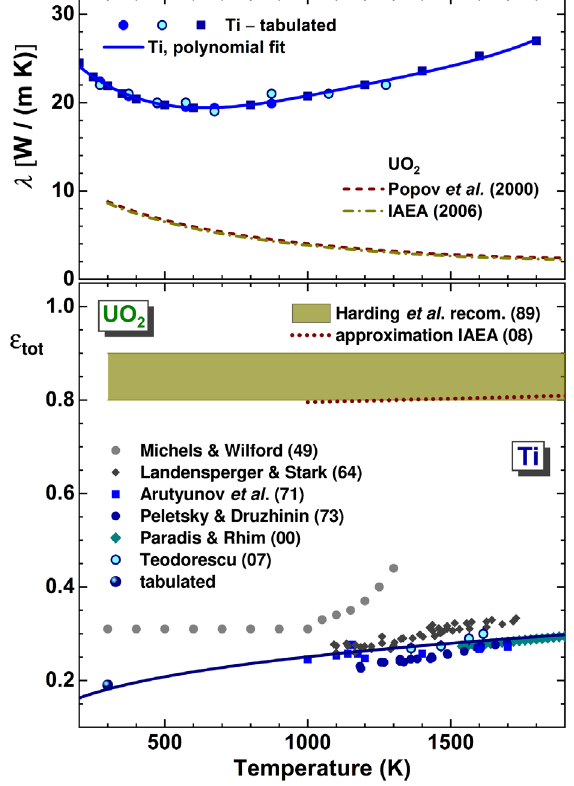
FIG. 2. Data on thermal conductivity coefficients λ for Ti (symbols) [22 – 24] and for UO 2 approximations (lines) [19,25] are shown as functions of temperature (upper panel). A solid line shows the result of the polynomial fit to the Ti data. In the bottom panel, the available data on total hemispherical emissivity ε Ti (symbols) [26 – 32] together with the aT b function fitting the data (solid line) and approximations for UO 2 (dotted line and filled area) [33,34] are